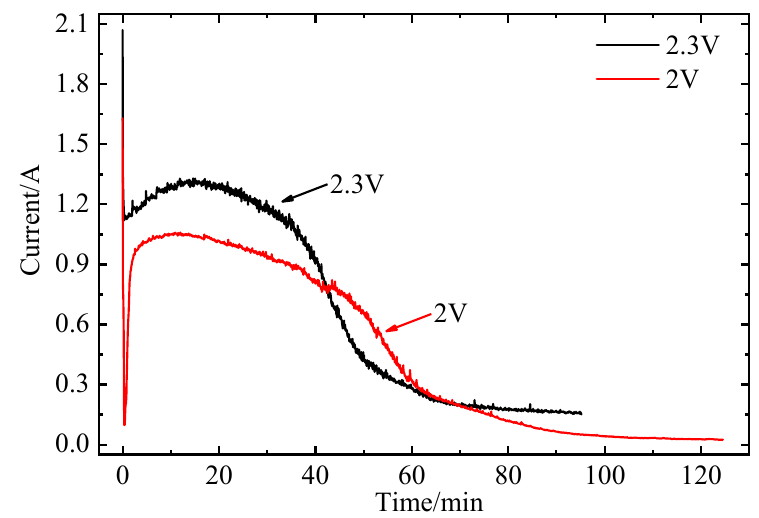
Figure 2. The current–time curve of electrolysis of molten salt (MnCl 2 (1.06 wt%)-FeCl 3 (2.69 wt%)-NaCl-KCl, 800 °C).